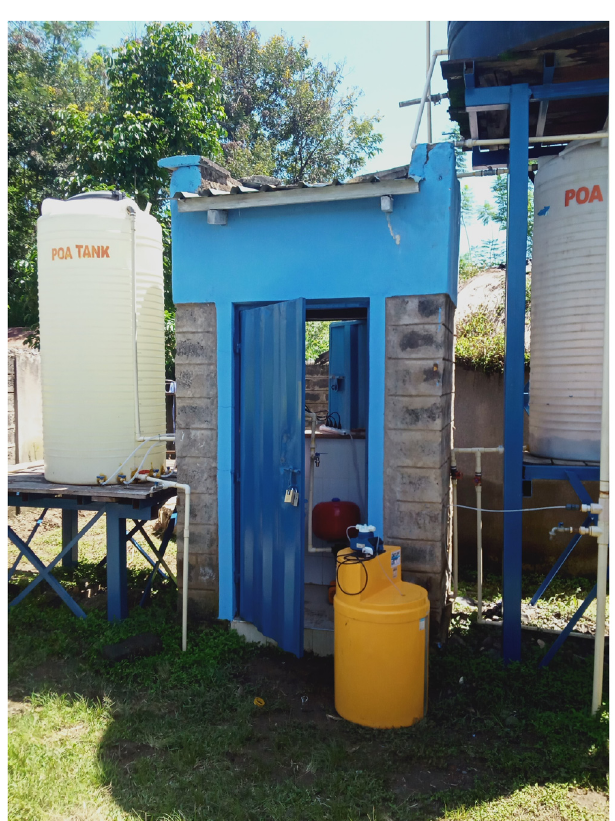
Figure 2. Utility housing. Upper right: The large black tank on the right is the settling tank; Right: The white tank is the balance tank; Left: The white tank is the ozonation tank. Tubing carrying ozone to the diffusers (not visible) can be seen entering the tank. Yellow container in the foreground contains